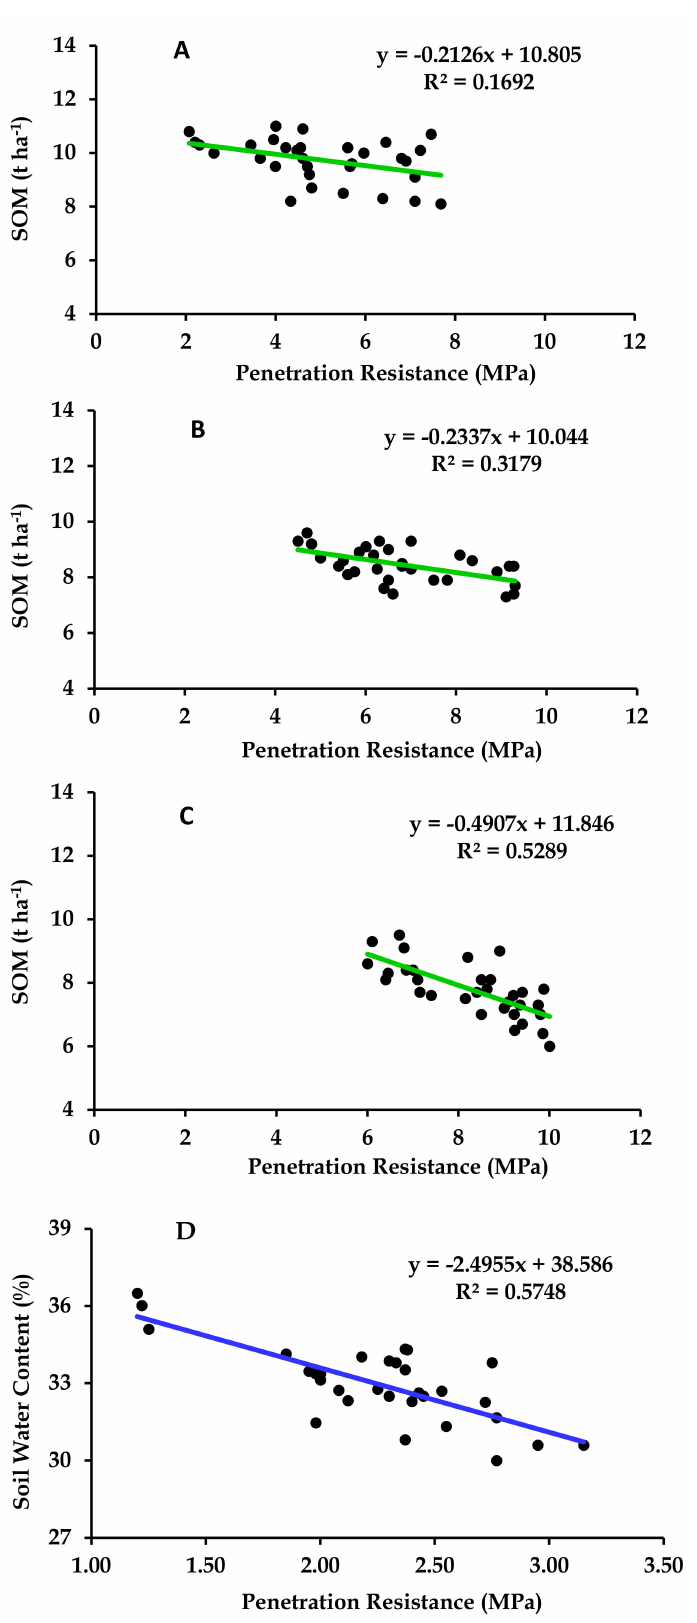
Figure 4. Relationship between penetration resistance and soil organic matter (( A ): 0–5 cm, ( B ): 5–10 cm, ( C ): 10–15 cm depth) and water content of soil ( D ) after completion of 8th